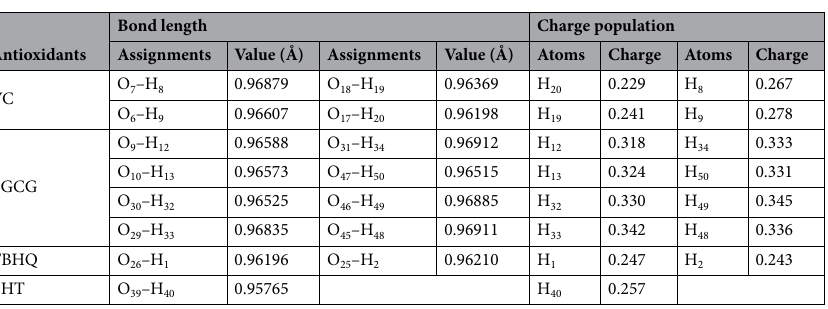
Table 4. Hydroxyl H–O bond lengths and accumulated charges on H atoms in four antioxidant molecules.